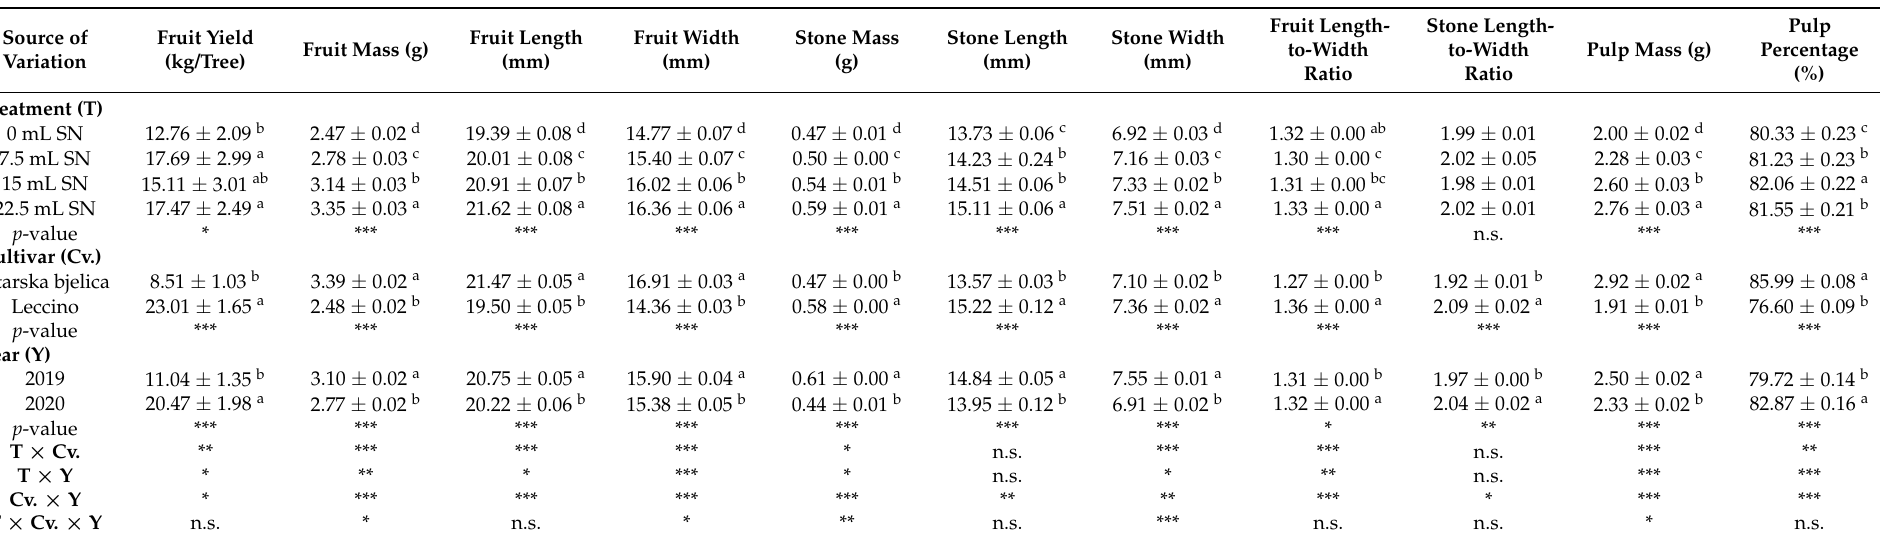
Table 3. The effect of treatment (T) (0, 7.5, 15, and 22.5 mL of applied SN foliar fertilizer per 1 L of water), cultivar (Cv.) (Istarska bjelica, Leccino), and collection year (Y) (2019, 2020) on fruit yield and fruit morphological